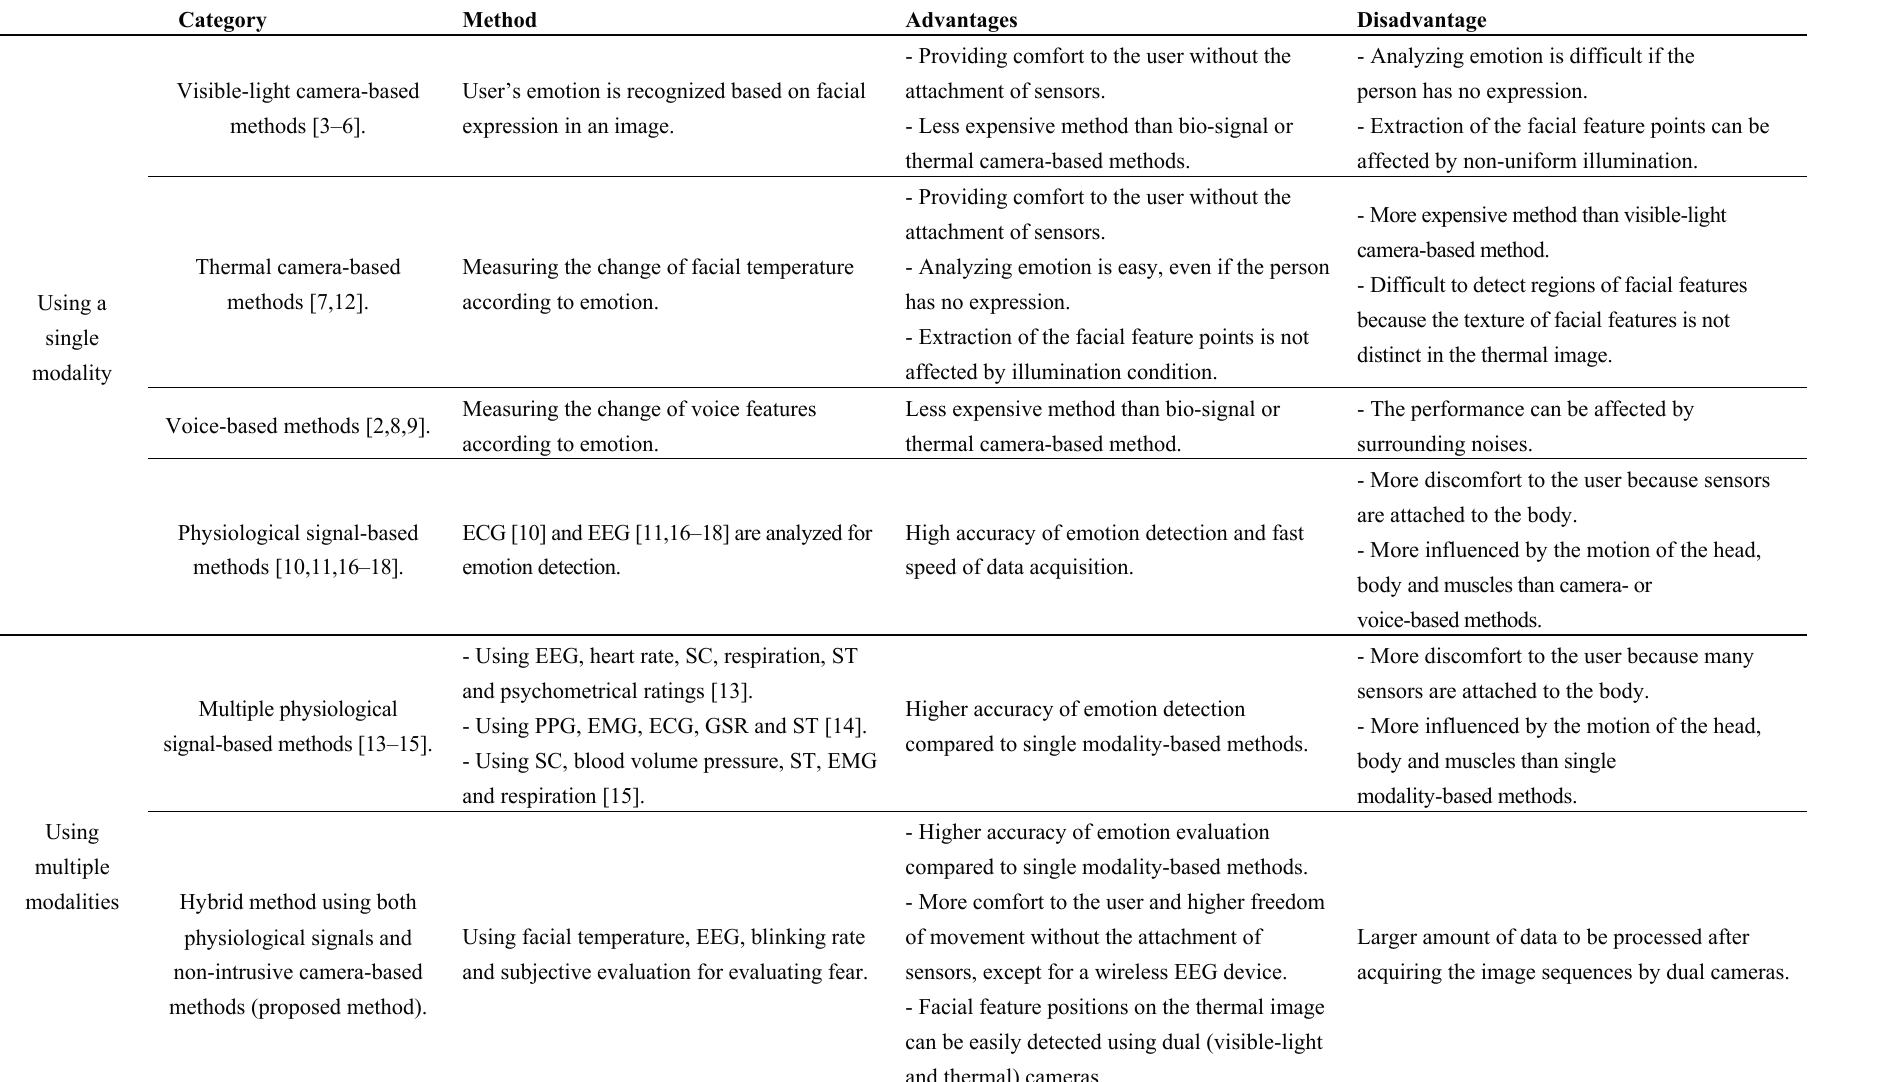
Table 1. Comparison between the previous methods and the proposed method of emotion